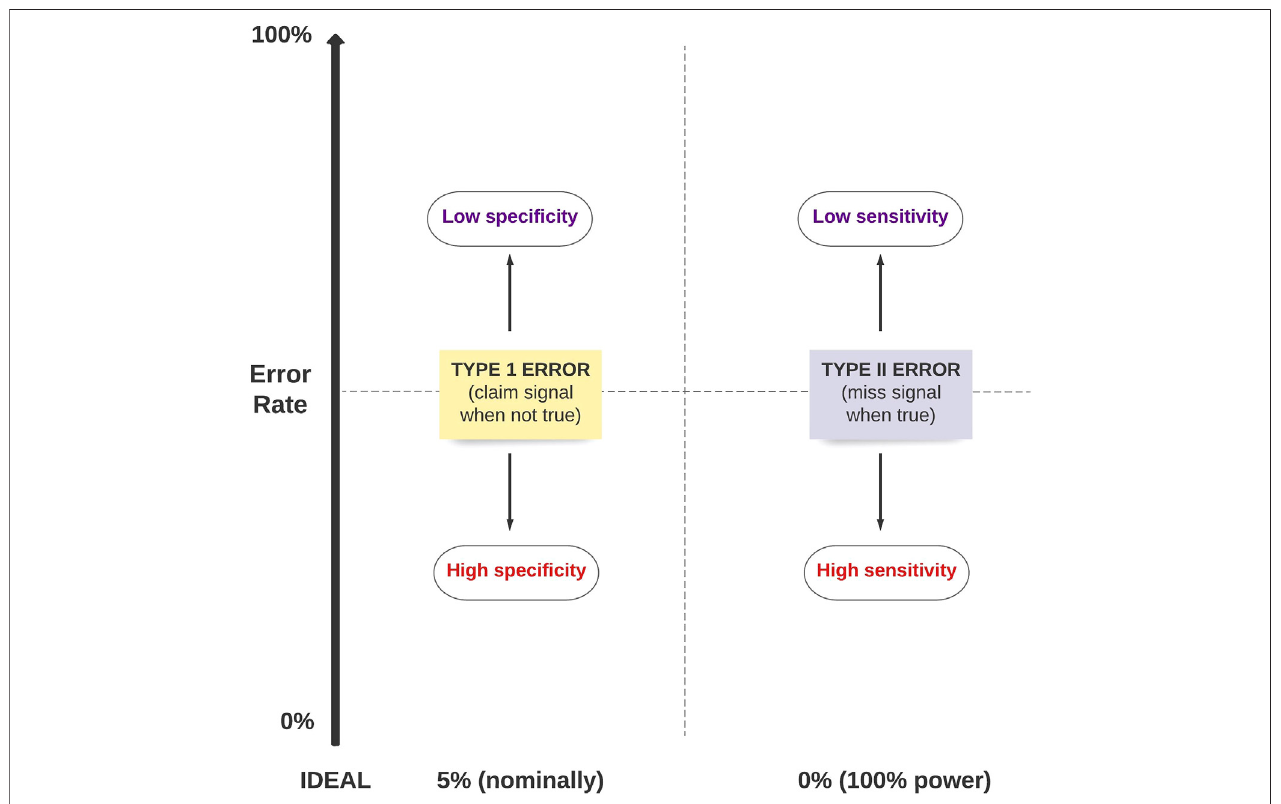
FIGURE 1 | The relationship between Type 1 error, Type II error, sensitivity and speci fi city of a test.